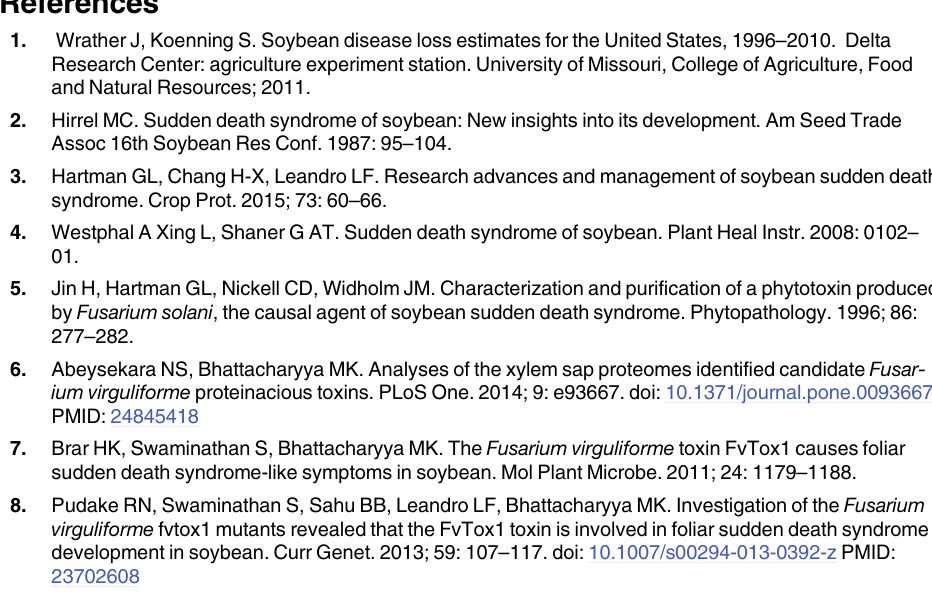
S1 Table. Primers used in this study. S2 Table. Nucleotide sequences of all nine peptides. S3 Table. Fusion peptides expressed in E . coli for pull down assay. S4 Table. Plasmid constructs included in this